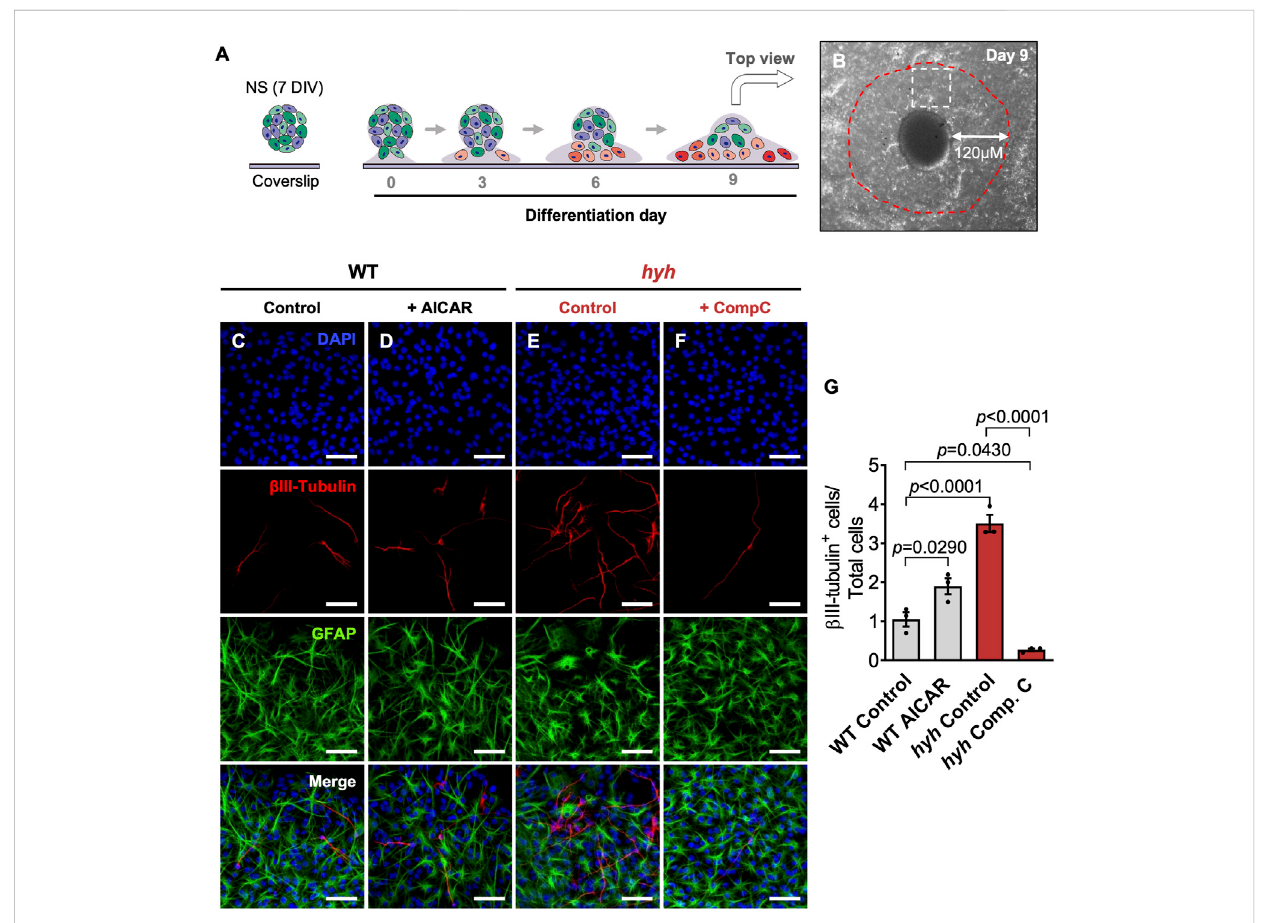
FIGURE 8 NSPCs derived from hyh mice differentiate preferentially towards the neuronal lineage, which is reversed through pharmacological modulation of AMPK. (A) . Scheme depicting the experimental design. Neurospheres (NS) (7DIV) from WT and hyh mice were transferred onto poly-l-lysine-coated coverslipsandculturedfor10 days(day0today9)inthepresenceof5%ofbovinefetalserumtoinducedifferentiation.After10 daysunderdifferentiation treatment, WT NS were treated with 5 mM AICAR and hyh NS with 10 μ M Compound C, for 24 h. Vehicle was used as control. (B) . Representative phase contrast image of 10DIV differentiating NS (top view). Differentiating neurons ( β III-tubulin + cells) were counted within a radius of 120 μ m from neurospheres(reddashedline).WhitesquarerepresentsanareasimilartothoseshowninC-F. (C – F) .Representativeimmunostainingfor β III-Tubulinand GFAP of differentiated WT and hyh NS under pharmacological modulation of AMPK. DAPI was used to stain nuclei. (G) . Quanti fi cation of β III-tubulin + cells. The bars represent the percentage of β III-tubulin + cells over the total number of cells (nuclei) (n = 3 for each condition). Differences with p < 0.05 were considered signi fi cant (One-way ANOVA with Bonferroni ’ s post-test). Scale Bars: C-F = 50